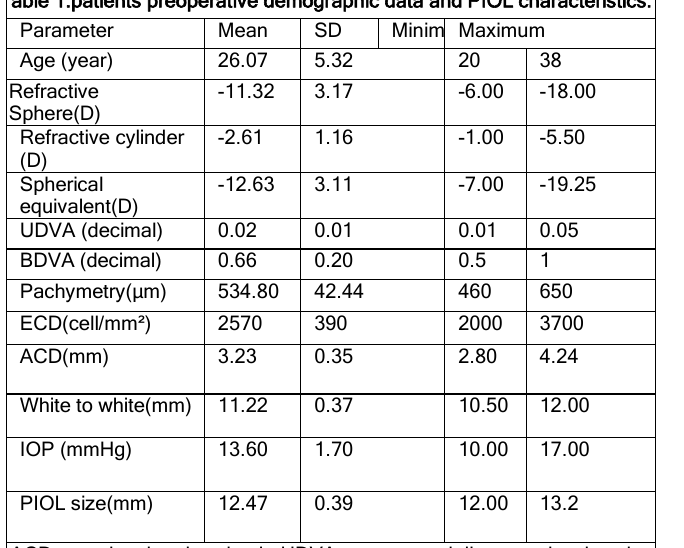
Table 1.patients preoperative demographic data and PIOL characteristics: